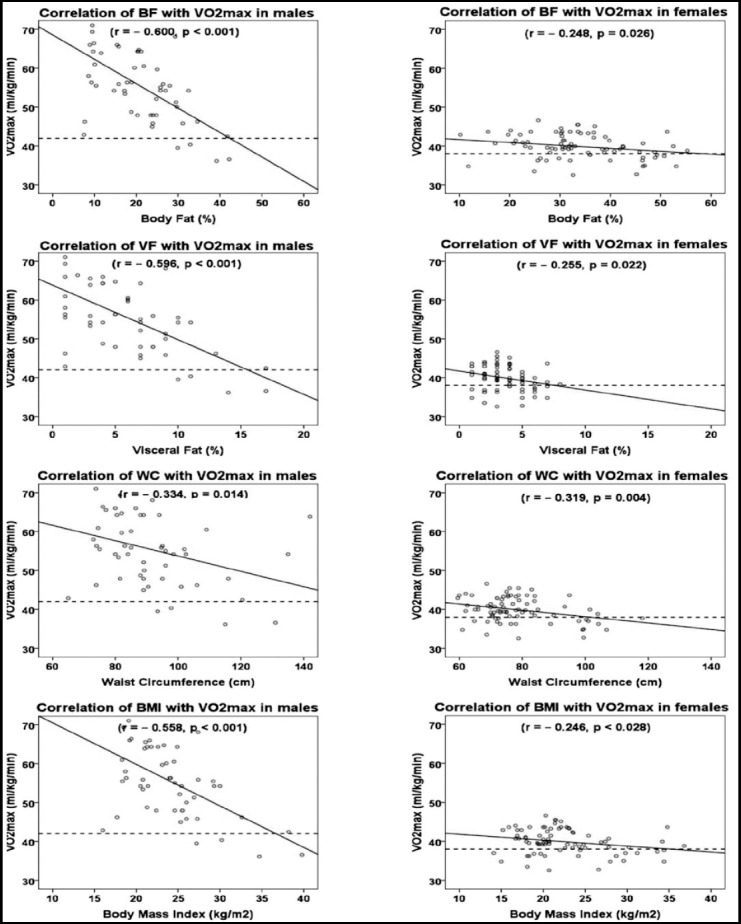
Correlation of Body Composition with VO2max.Scatter plot showing correlation (r) of body fat (BF), visceral fat (VF), waist circumference (WC) and body mass index (BMI) with maximum O2 uptake (VO2max) in males and females. Dotted line indicates cutoff point of VO2max taken as lower limit of average VO2max for this age group according to standard charts; 42 ml/kg/min in males, 38 ml/kg/min in females.